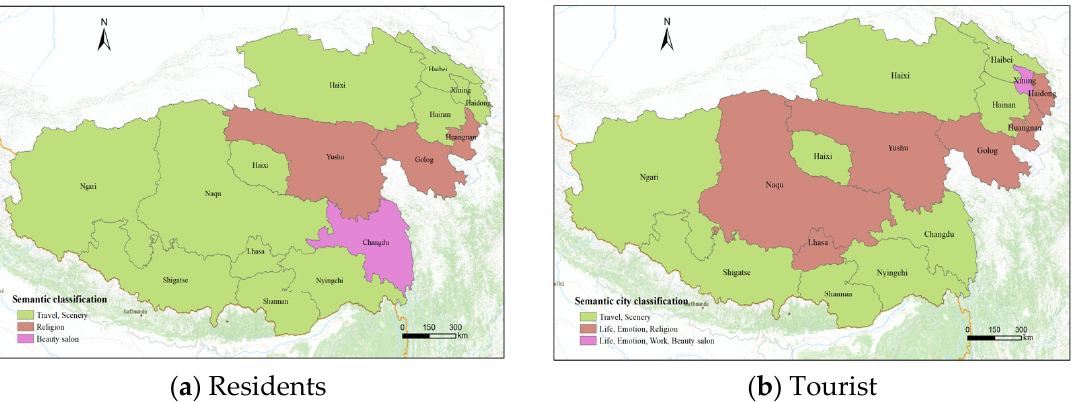
Figure 11. Classification of cities in the Qinghai–Tibetan Plateau according to their semantic similarity for ( a ) residents and ( b ) tourists.